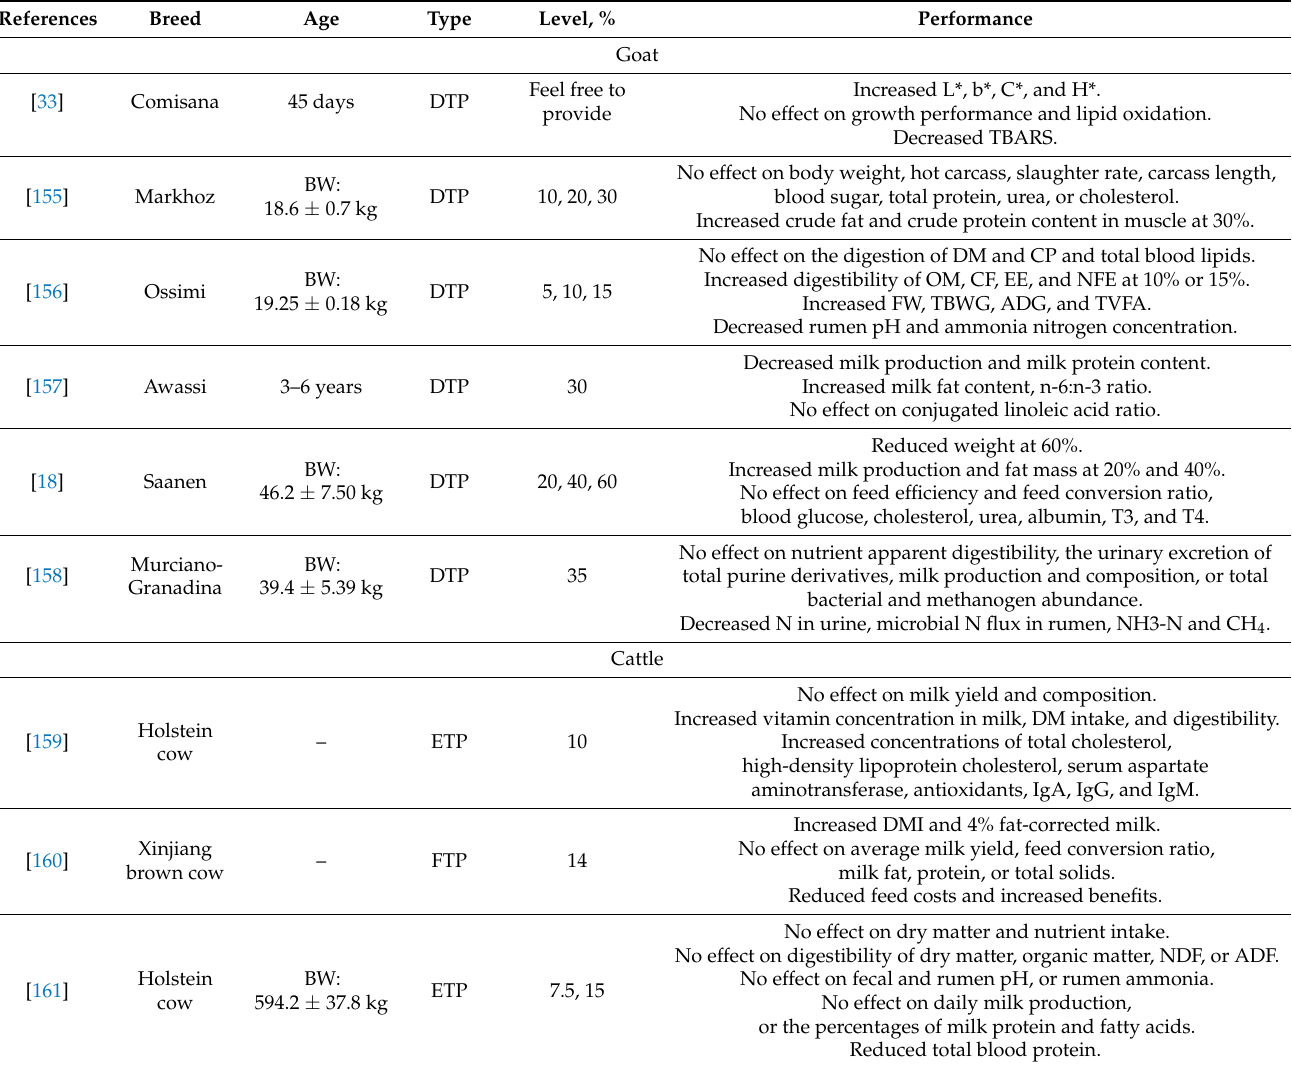
Table 8. The effects of tomato pomace on